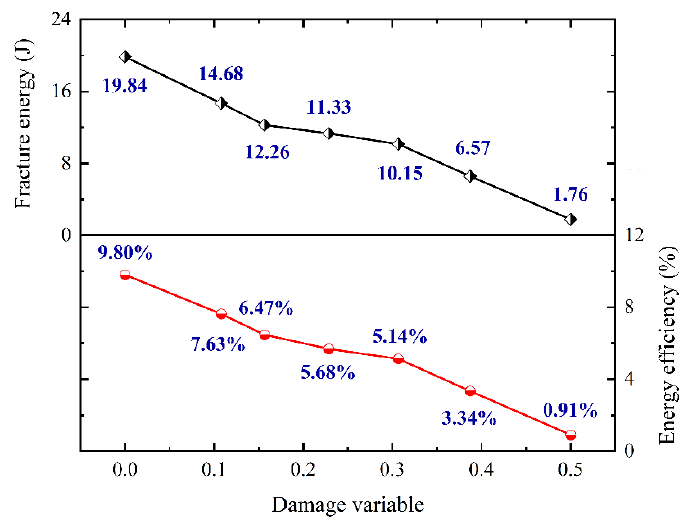
Figure 19. Variation of fracture energy and energy efficiency with accumulated damage variable.